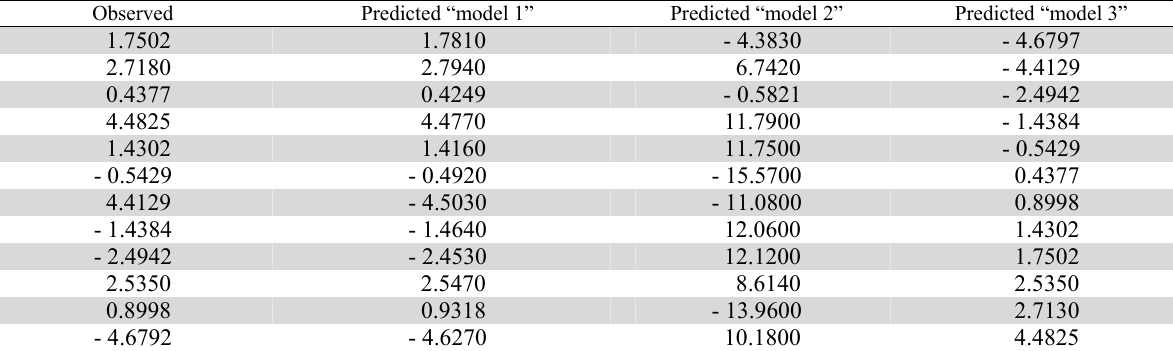
Observed and predicted